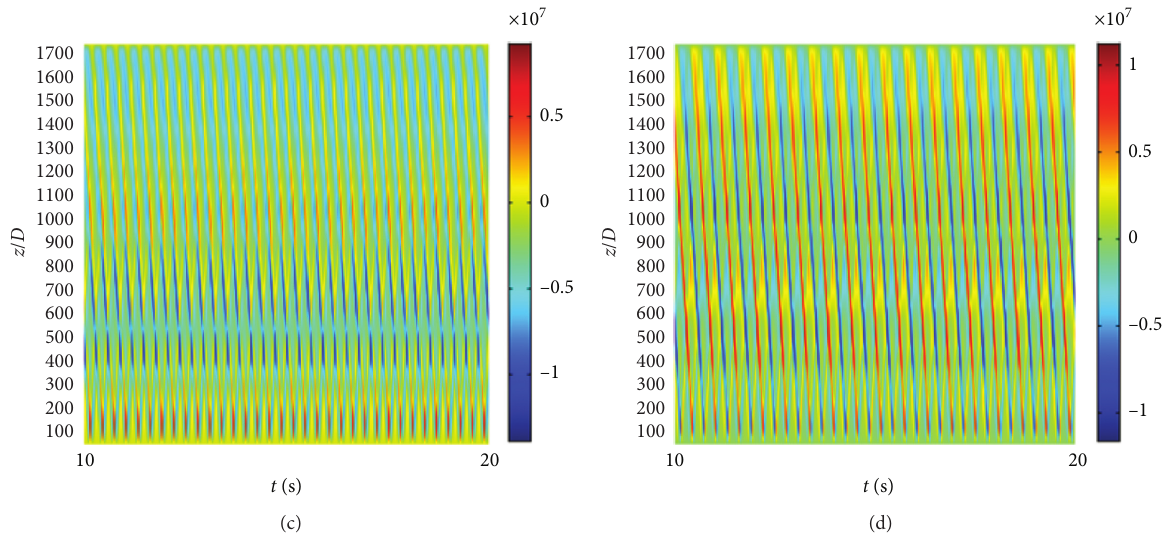
Figure 12: Space-time response of stress of the marine riser under different axial tension excitation amplitudes. (a) The in-line and (b) cross- flow with A / D � 1.2. (c) The in-line and (d) cross-flow with A / D � 3.0.